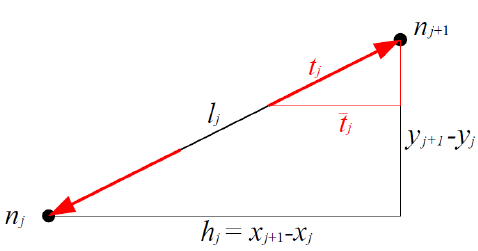
Figure 1: A schematic view of the thrust line